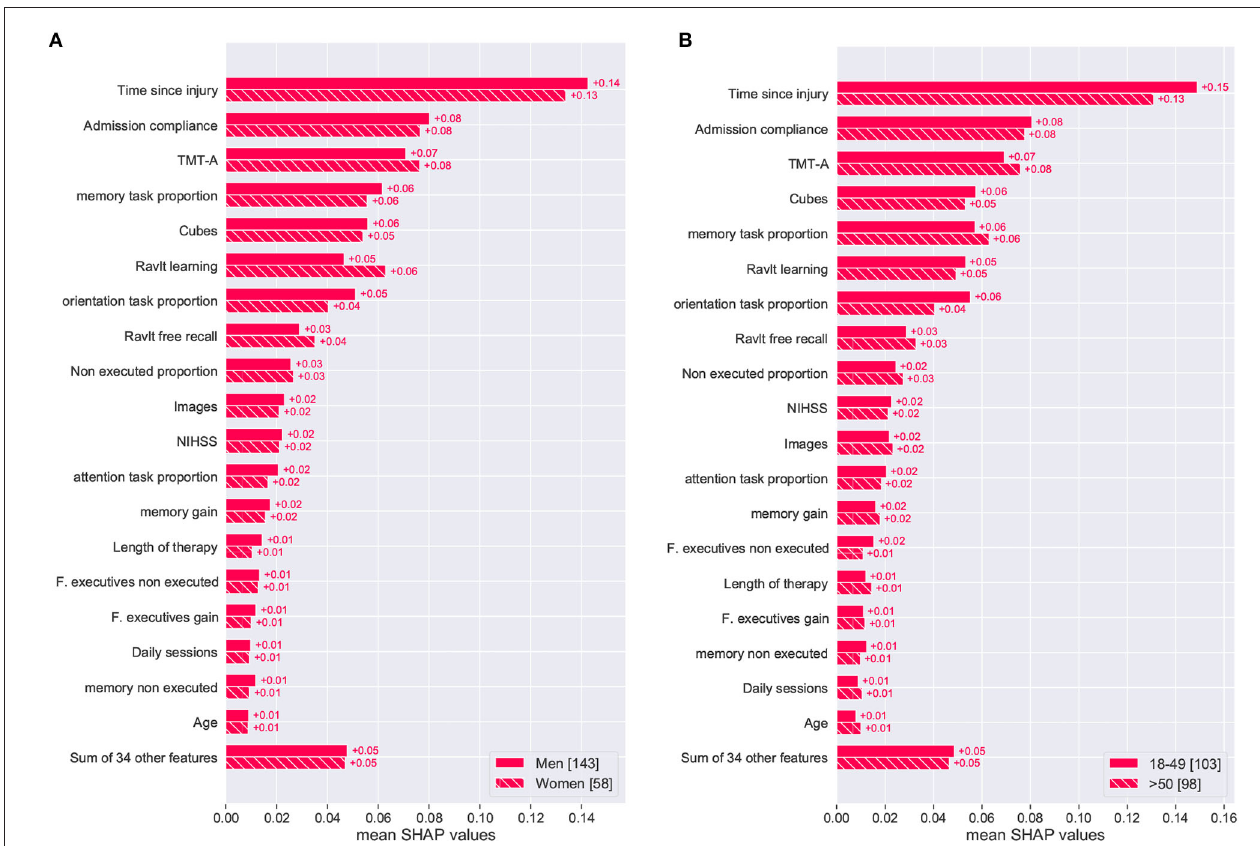
FIGURE 6 | Global feature importance plot based on mean SHAP values for sex (A) and age (B) cohorts of patients. Results from the XGBClassifier_All optimized